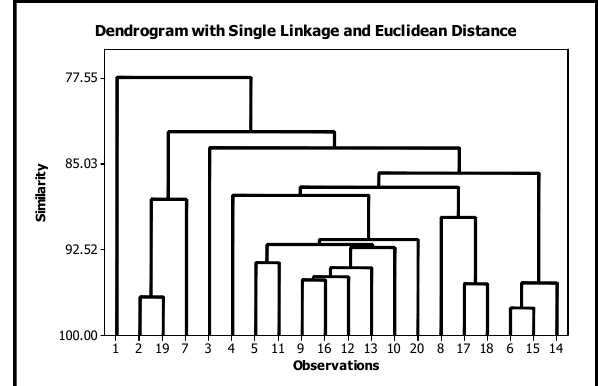
Fig. 1.Genetic grouping of local bean populations by